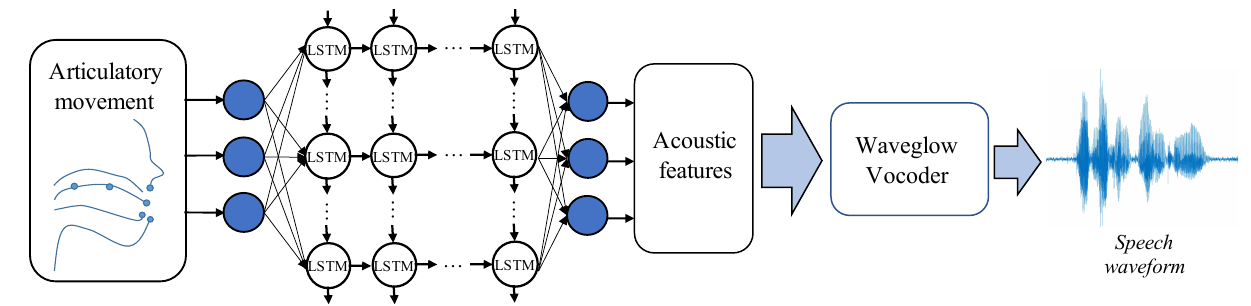
Figure 1. The overview illustration of a generic articulation-to-speech synthesis